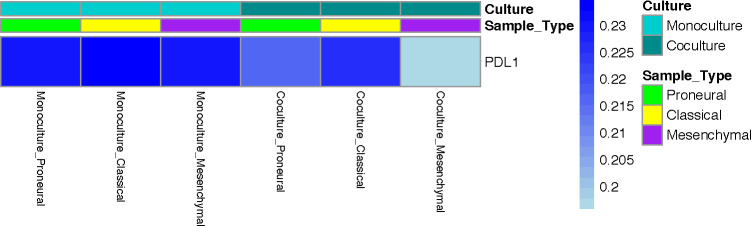
PD-L1 promoter methylation in mono-cultured and co-cultured GBM cells in a 3D brain-mimicking ECM environment.The absence or presence of macrophages does not induce changes in methylation of the PD-L1 gene promoter.